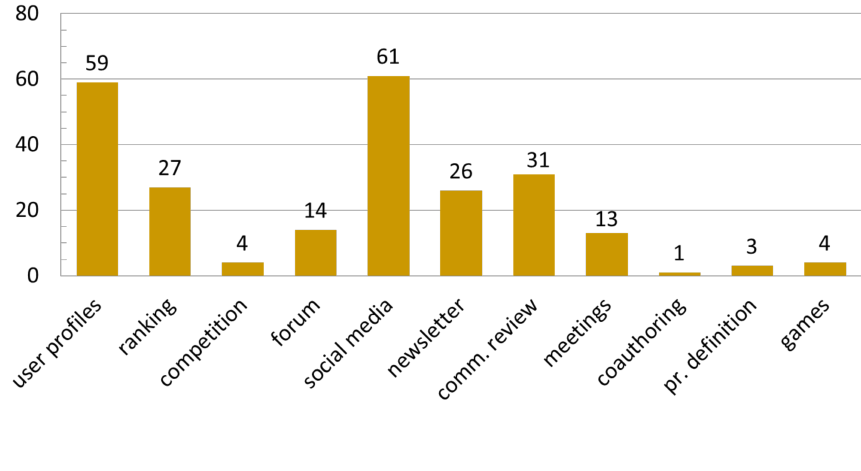
Figure 16. Summary of the results relative to the user interaction and participation